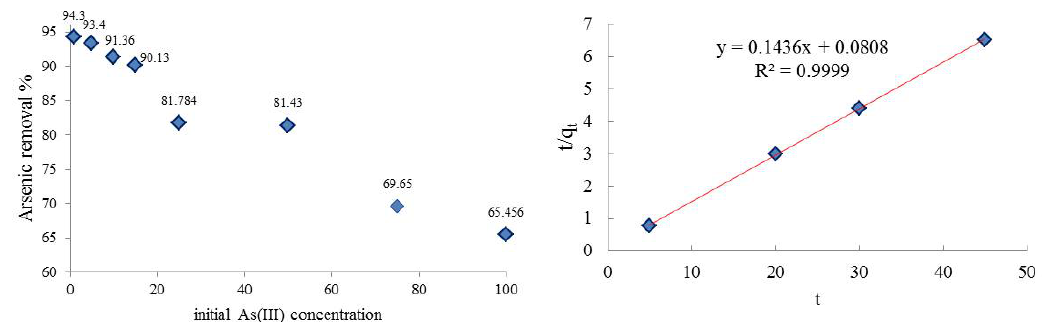
Fig. 11. plot of t/q against t that can show pseudo second-order t kinetics for adsorption of As(III) Fig. 11 plot of t/q t against t that can show pseudo second-order kinetics for adsorption of As(III).